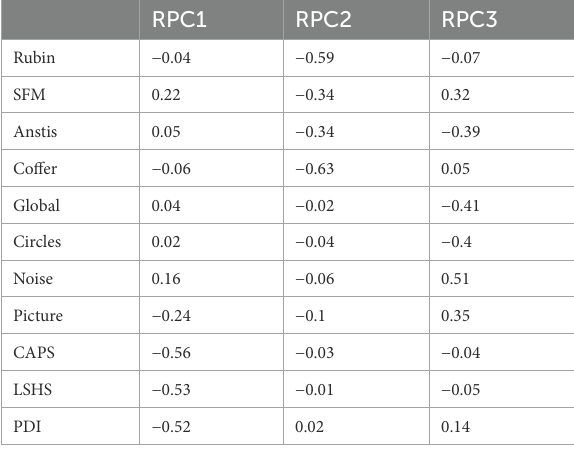
TABLE 1 Variable contribution to the 3 PCA components after varimax